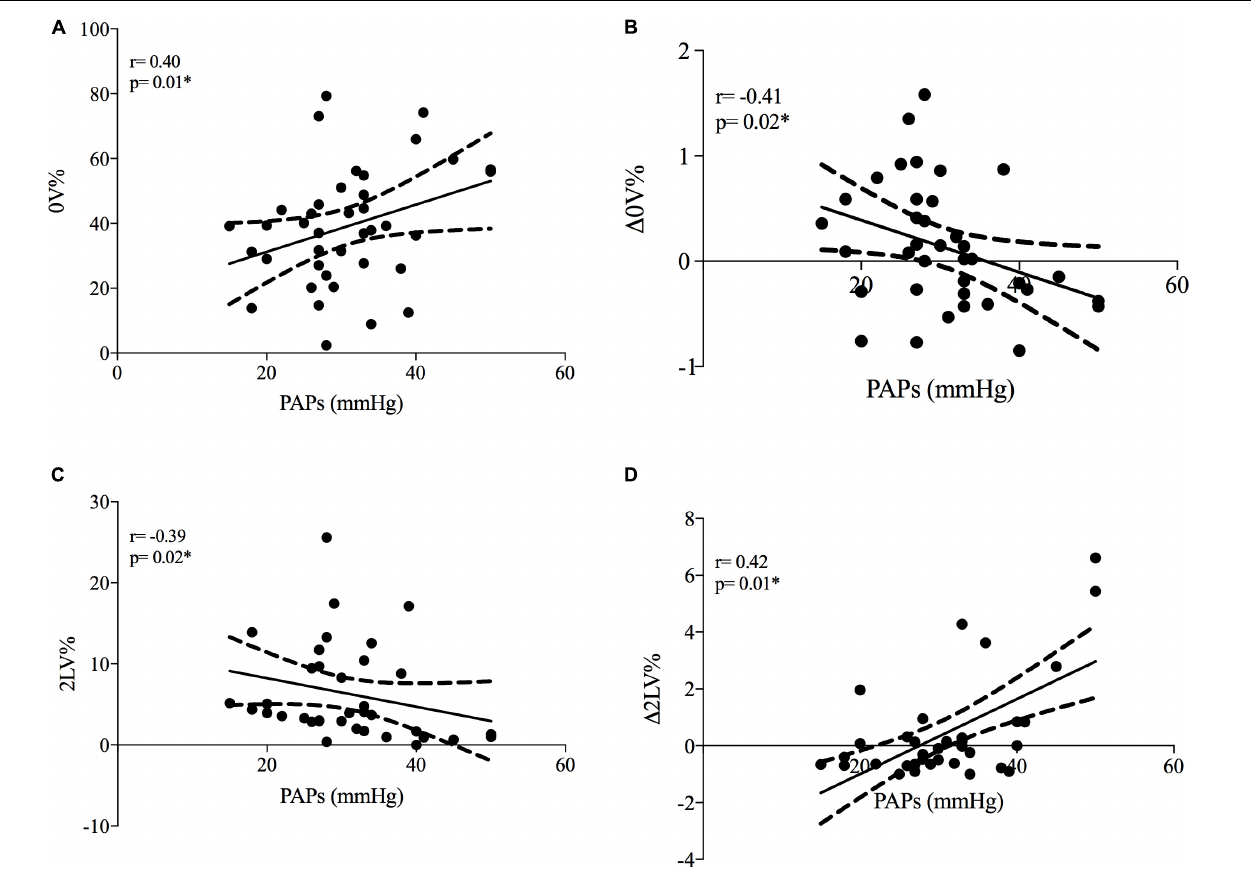
FIGURE 1 | Correlations between systolic pulmonary artery pressure and cardiac autonomic modulation in SSc patients. PAPs, systolic pulmonary artery pressure; (cid:49) 0V%, [(0V% in supine position-0V% in orthostatic position)/0V% in supine position]. 0V% and 2LV% are non-linear heart rate variability markers of sympathetic and vagal modulation. Plots (A,B) represent cardiac sympathetic modulation at rest and sympathetic dynamic response to ORT, respectively. Plots (C,D) represent cardiac vagal modulation at rest and vagal dynamic response to ORT, respectively. ∗ p < 0.05 from Spearman’s